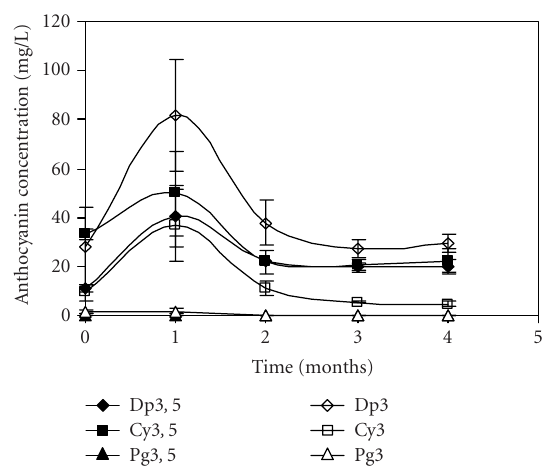
Figure 6. Evolution of delphinidin 3,5-diglucoside (Dp3,5), cyanidin 3,5-diglucoside (Cy3,5), pelargonidin 3,5-diglucoside (Pg3,5), delphinidin 3-glucoside (Dp3), cyanidin 3-glucoside (Cy3), and pelargonidin 3-glucoside (Pg3) concentration in “As- saria” pomegranate juice from fruits treated with 1 . 5% CaCl 2 , during storage at 5 ◦ C. The concentrations of anthocyanins were calculated from standard curves of Dp3,5; Dp3; Cy3,5; Cy3, Pg3,5, and Pg3. Bars represent standard deviations of four repli- cates.